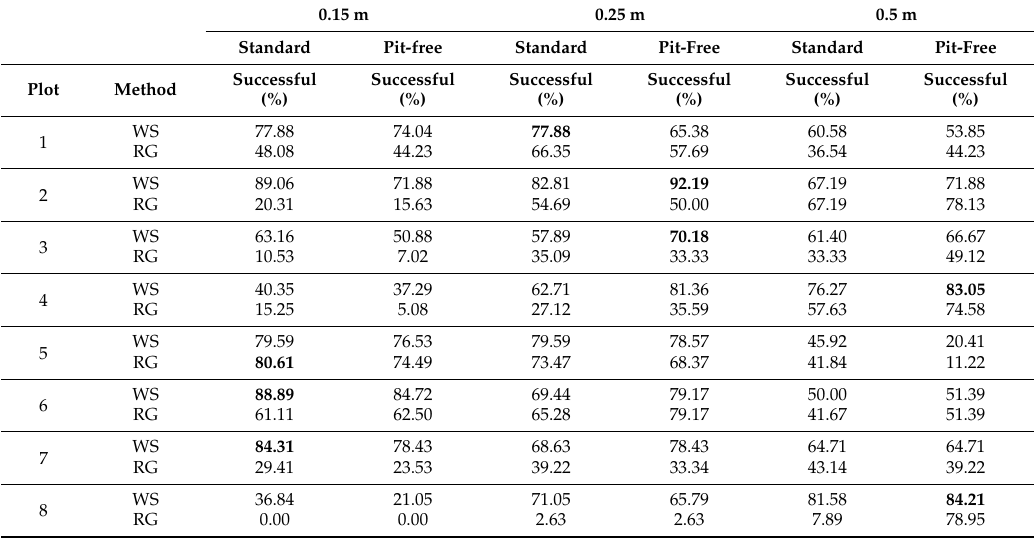
Table 7. Successful delineation percentages for all segmentation algorithm, CHM generation method and CHM pixel size combinations tested for all sample plots.